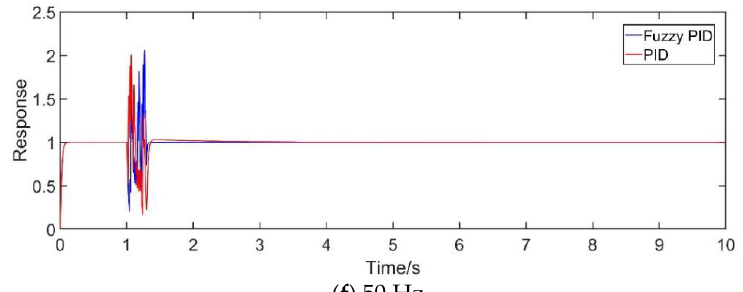
Figure 8. Step response after adding interference. ( a ) response curve of interference signal frequency of 3Hz. ( b ) response curve of interference signal frequency of 10Hz. ( c ) response curve of interference signal frequency of 20Hz. ( d ) response curve of interference signal frequency of 30Hz. ( e ) response curve of interference signal frequency of 40Hz. ( f ) response curve of interference signal frequency of 50Hz. Table 3. Response results of control system.